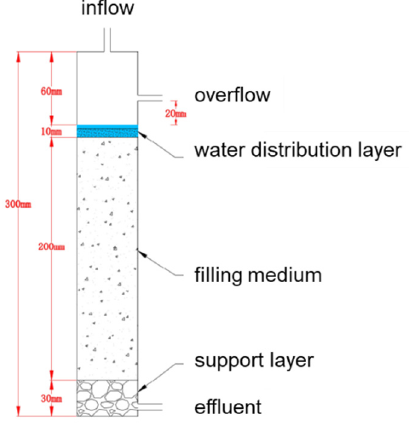
Figure 1. Schematic diagram of the packed soil column.